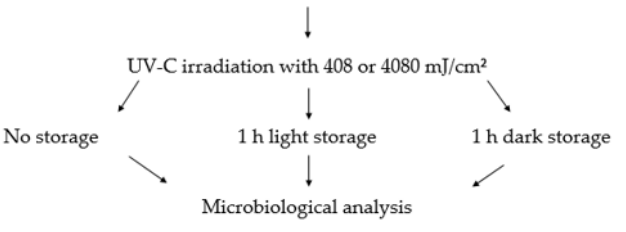
Figure 1. Overview of the experiments performed in the present study.